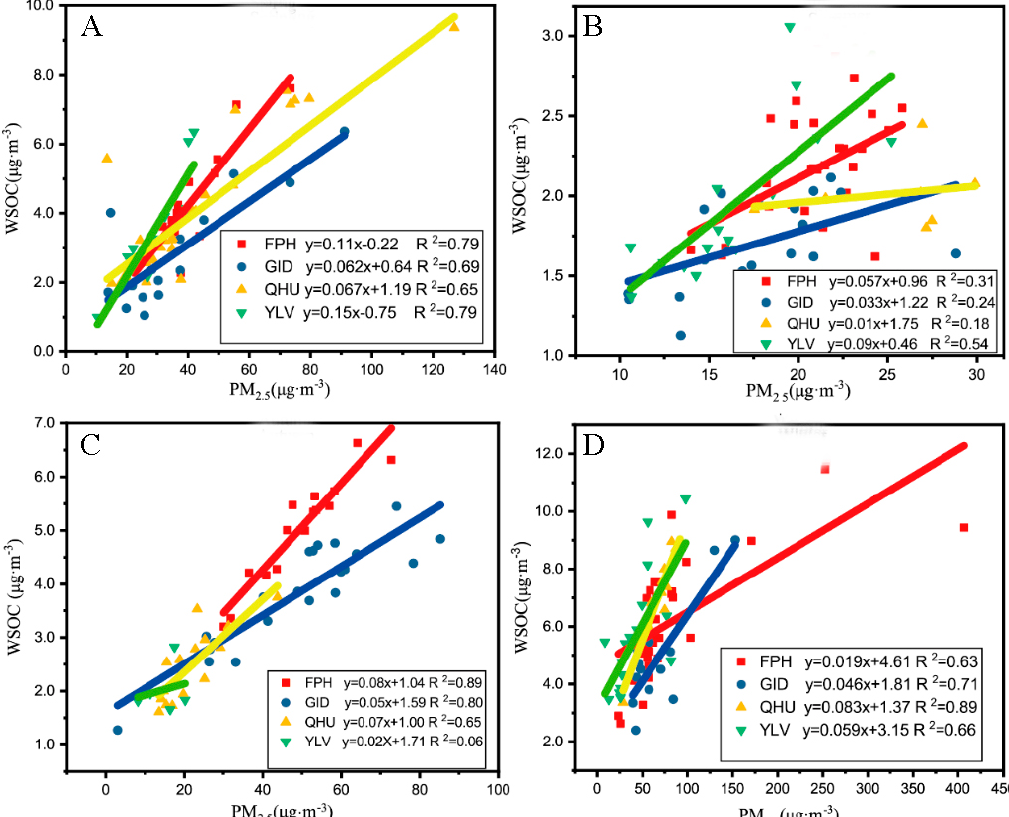
Figure 2. Regressions between water-soluble organic carbon (WSOC) and PM 2.5 at the four sampling sites. Note: ( A ) = Spring, ( B ) = Summer, ( C ) = Autumn, (D ) = Winter.